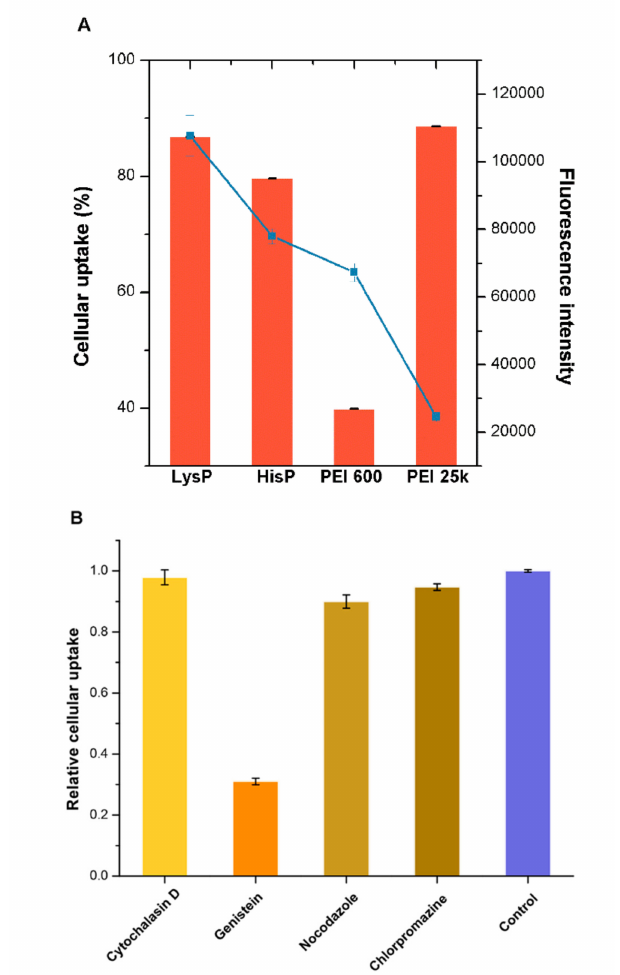
Figure 7. ( A ) Cellular uptake percentage (column) and relative fluorescence intensity (RFI, dot) of polymer / DNA complexes at optimal transfection w / w ratio in B16 cells. PEI 25 kDa ( w / w = 1.4) was used as control. ( B ) Relative cellular uptake of HisP / DNA complexes at the optimal ratio in B16 cells in the presence of various endocytic inhibitors quantified by flow cytometry